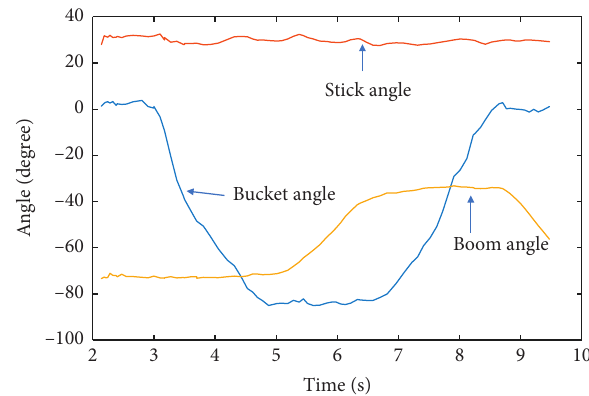
Figure 13: The trajectory of the excavator arm in the joint space in the 2 nd real-time experiment. The trajectory of the excavator arm is adjusted as the dug weight is out of the acceptable range; so, the weight error is kept small.